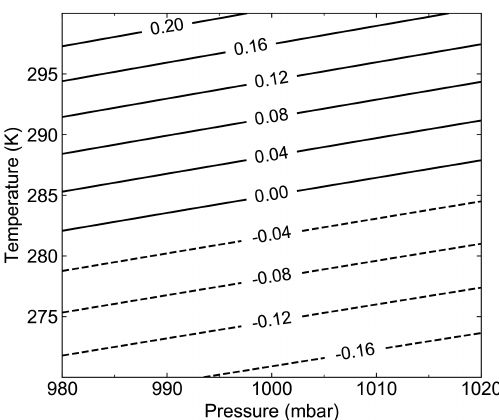
Figure C1. Humidity error for assumed temperature T 0 = 285K and pressure P 0 = 1000mbar versus actual values T and P